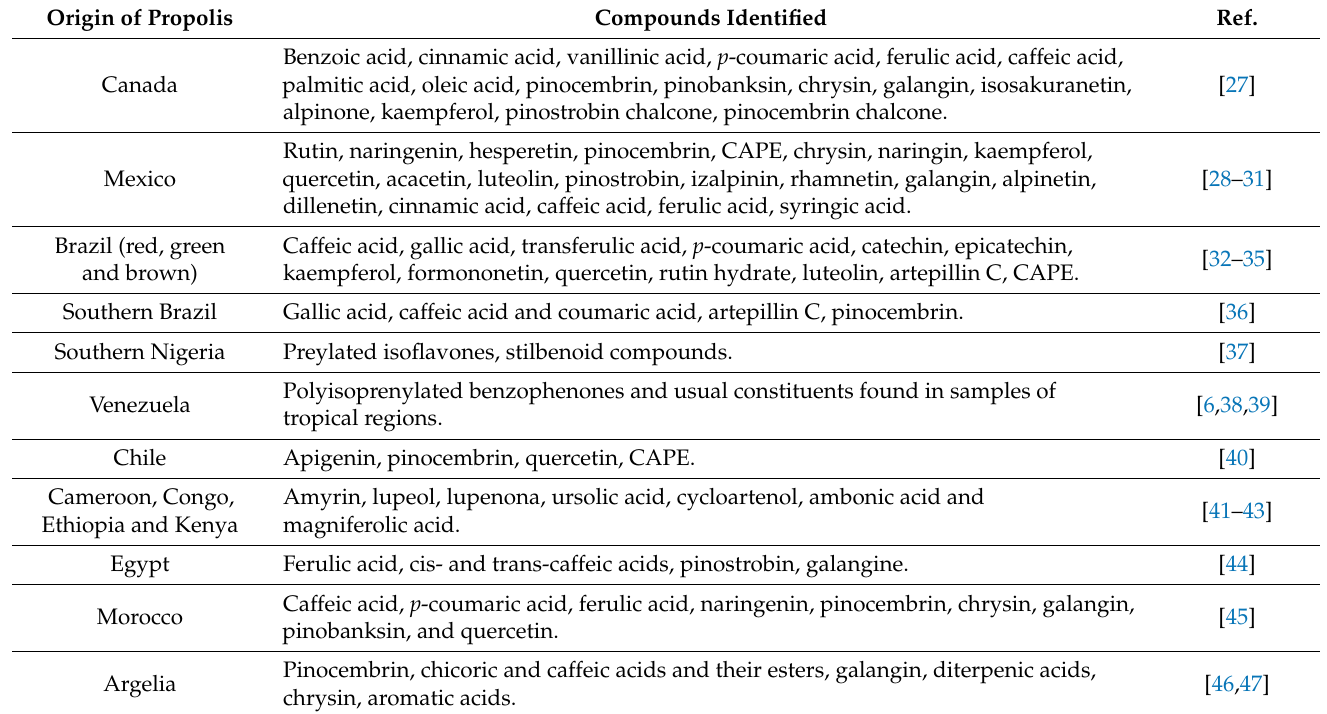
Table 1. Main compounds identified in propolis from different regions of the world. Compounds Identified